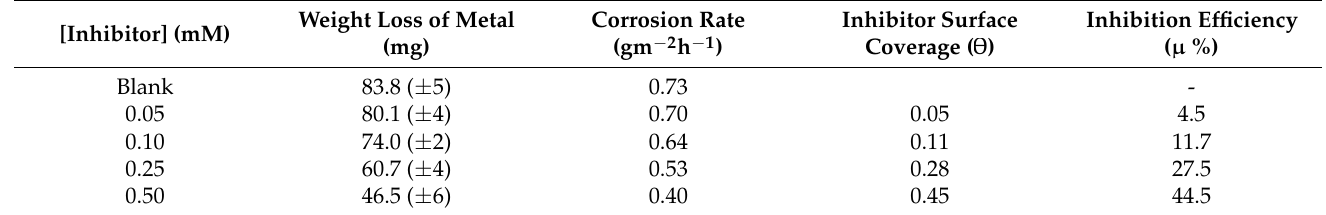
Table 1. Calculated weight loss, corrosion rate, and inhibition efficiency without and with various concentrations of P2T.